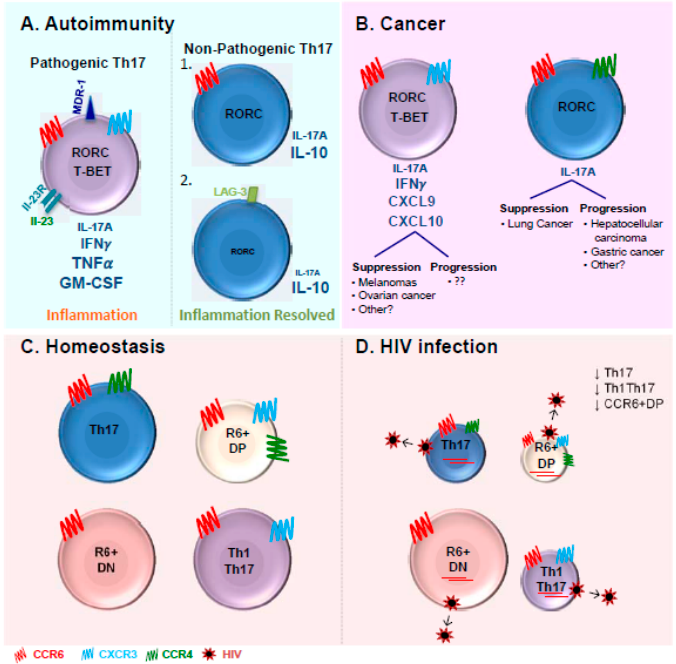
Figure 1. The Th17 lineage heterogeneity during homeostasis and disease pathogenesis. This figure summarizes the heterogeneity of Th17 cells as discovered in mice and/or humans. ( A ) The concept of pathogenic versus non-pathogenic Th17 cells was originally established in the context of autoimmunity. Pathogenic Th17 cells are characterized by their ability to produce pro-inflammatory cytokines such as IL-17A, TNF- α , GM-CSF, and IFN- γ . These cells are identified as Th1Th17 or Th1* cells. They express on their surface the drug efflux pump MDR-1 and the receptor for IL-23, a cytokine found to promote pathogenic Th17 cell features. At the opposite, non-pathogenic Th17 cells are characterized by their ability to produce the immune-suppressive cytokine IL-10 or to express LAG-3; ( B ) the long-lived properties of certain Th17 subsets raised their potential contribution to cancer progression. However, the role of Th17 cells remains controversial and appears to vary from beneficial to deleterious depending on the type of cancer. Future studies are required to clarify these differences; ( C , D ) in humans, four subsets of CCR6+ Th17 cells were identified by our group based on their differential expression of CCR4 and CXCR3, as follows: CCR4+CXCR3 − (Th17), CCR4 − CXCR3+ (Th1 Th17 or Th1*), CCR4 − CXCR3 − (double negative, CCR6+DN), and CCR4+CXCR3+ (double positive, CCR6+DP). In HIV-uninfected individuals (C), Th17, Th1Th17, and CCR6+DN subsets are present in the blood at similar frequency, whereas CCR6+DP cells are less predominant. In chronically HIV-infected individuals receiving viral suppressive antiretroviral therapy (ART) (D), the frequency of Th17, Th1Th17, and CCR6+DP is dramatically decreased. However, the frequency of CCR6+DN cells is preserved in the blood and this subset is the most predominant in the lymph nodes of ART-treated individuals.